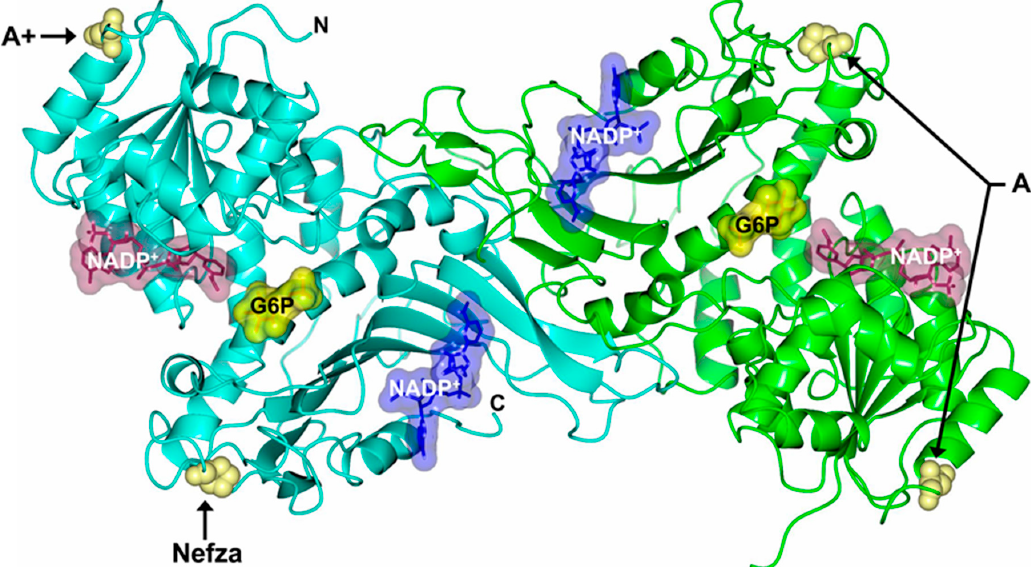
Figure 1. Structure of human Glucose-6-phosphate dehydrogenase (G6PD) dimer (Protein Data Bank entries 2BHL and 2BH9) indicating the location of Class III mutations Nefza (L323P), A+ (N126D), and A − (N126D + L323P) (yellow spheres). Structural nicotinamide adenine dinucleotide phosphate (NADP + ), catalytic NADP + , and glucose-6-phosphate (G6P) are drawn as blue, dark purple, and yellow molecular surface representations, respectively. Monomers are shown in cyan and green. The same color code is used in all other figures.